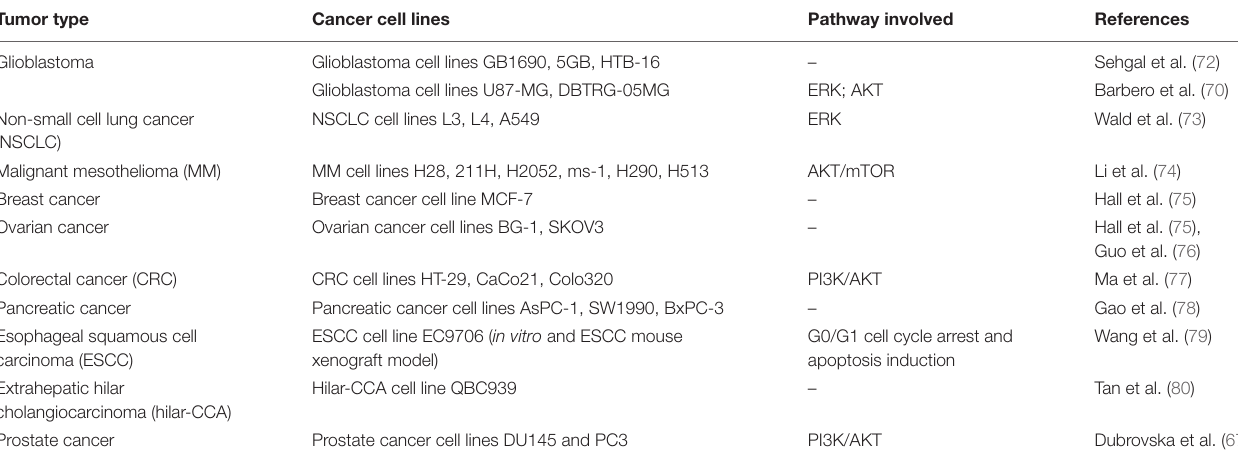
TABLE 1 | CXCR4/CXCL12 axis is involved in cancer cell proliferation.